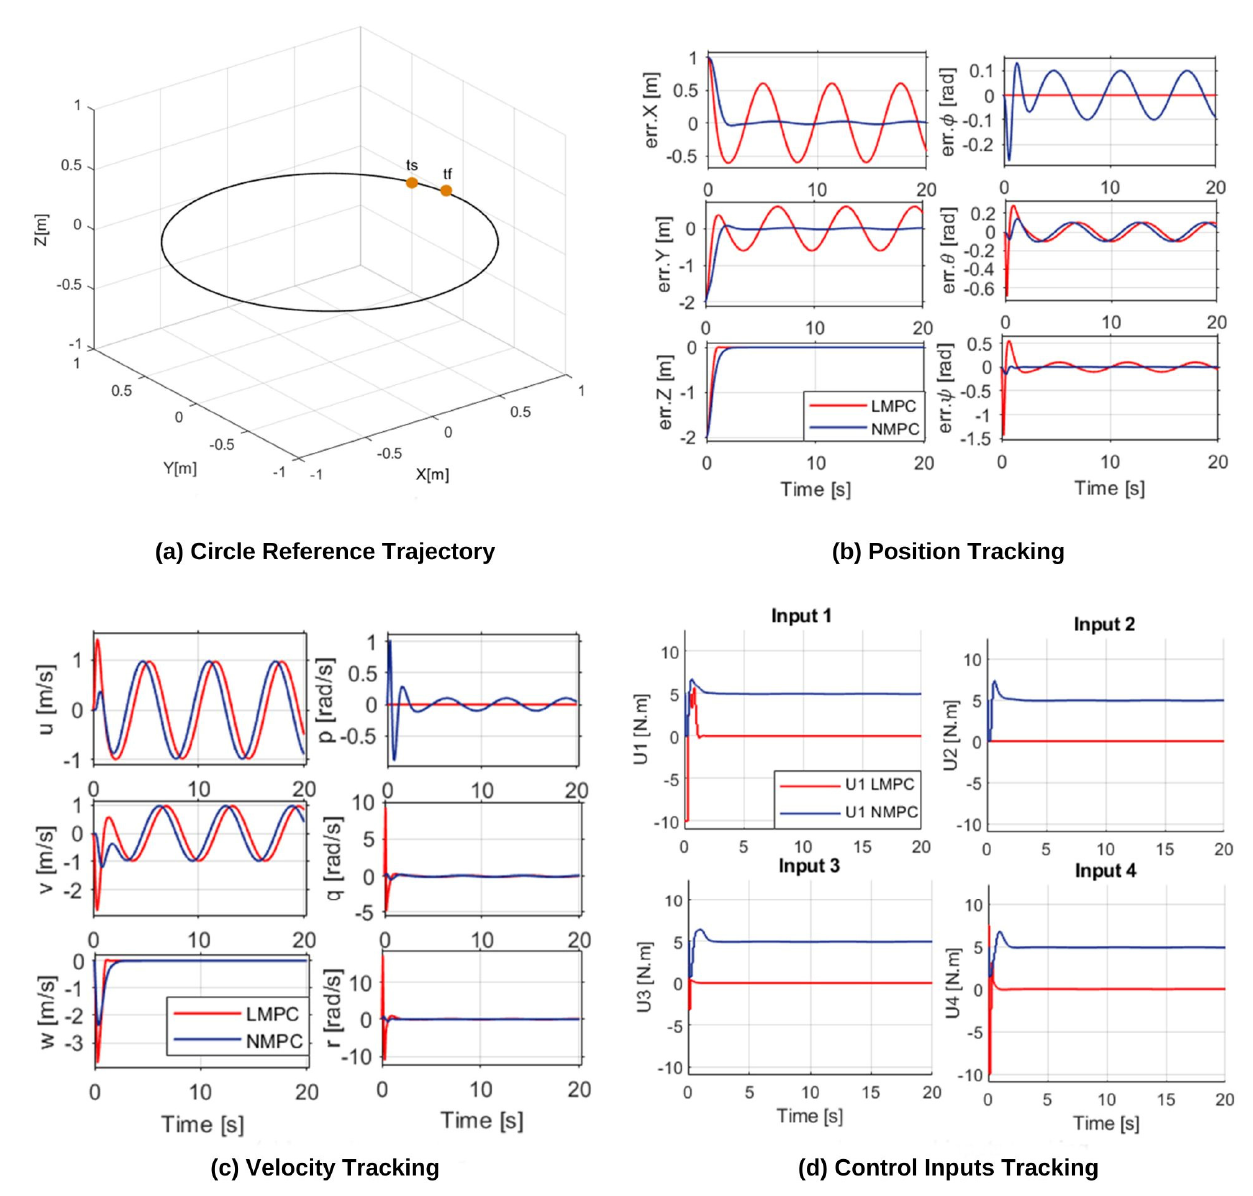
Figure 10. Circular reference trajectory.